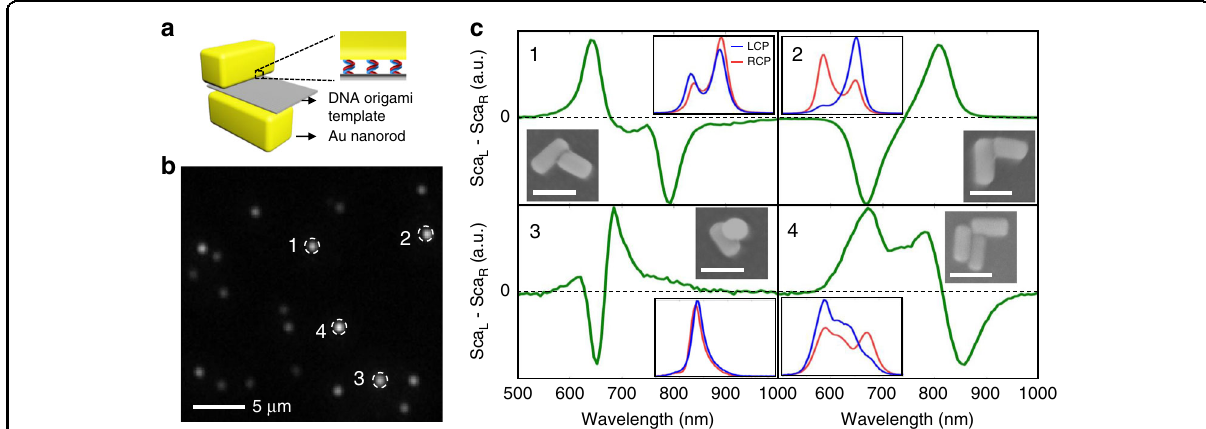
Fig. 4 SCD spectroscopy of single DNA-assembled 3D nanostructures. a Schematic drawing of the 3D DNA-assembled Au nanorod pairs. b The dark- fi eld image of the sample. c The SCD spectra of the spots labeled in ( b ) and the correlated SEM images. The blue and red lines in the insets are the left-hand and right-hand circularly polarized components of the scattering spectra of the structures, respectively. Scale bar: 100